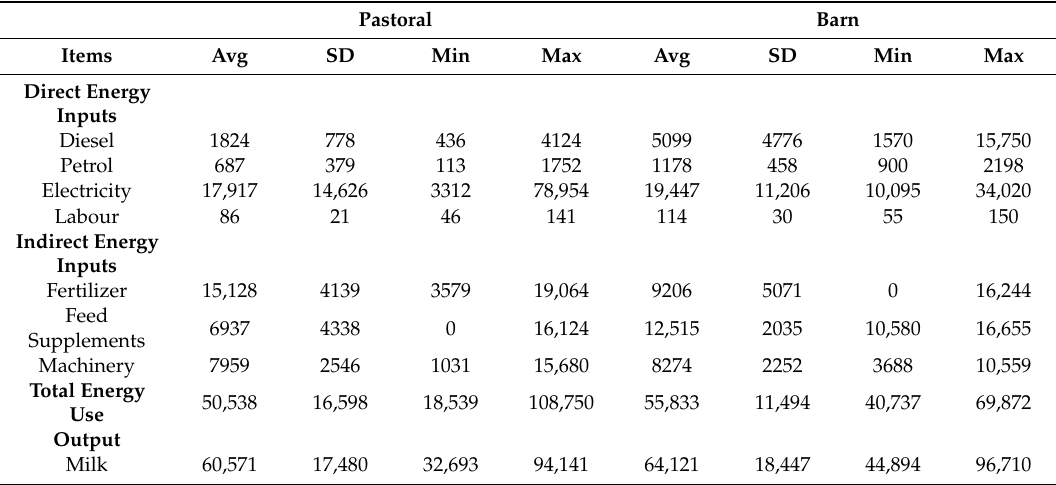
Table 2. Energy use of pastoral (PDFs) and barn (BDFs) dairy farming systems (MJha − 1 ).